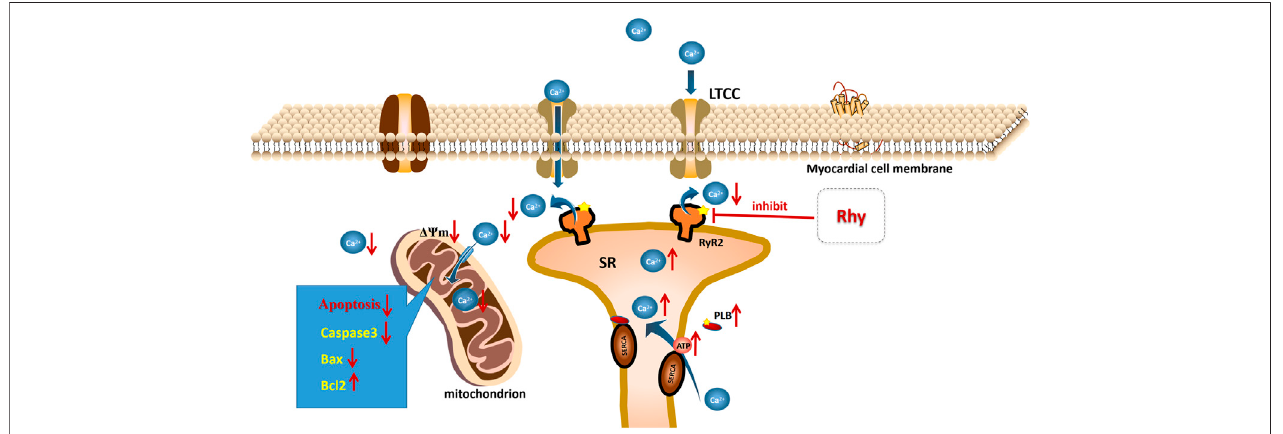
FIGURE 10 | Mechanism of rhynchophylline to improve diabetic